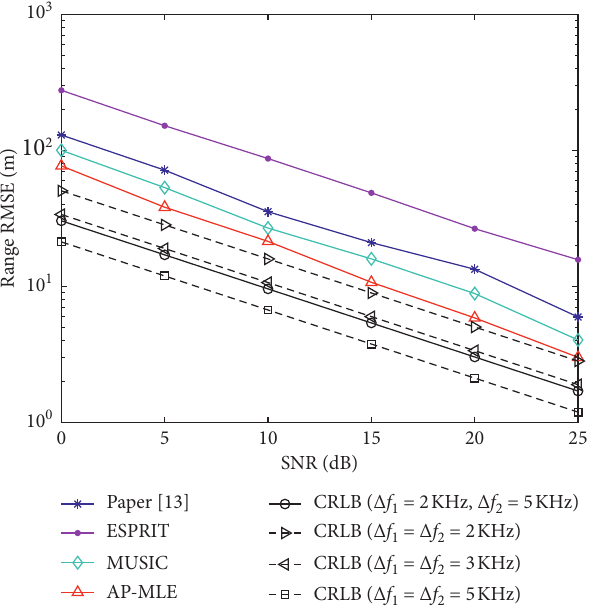
Figure 8: Range CRLB and RMSE curves versus SNR.